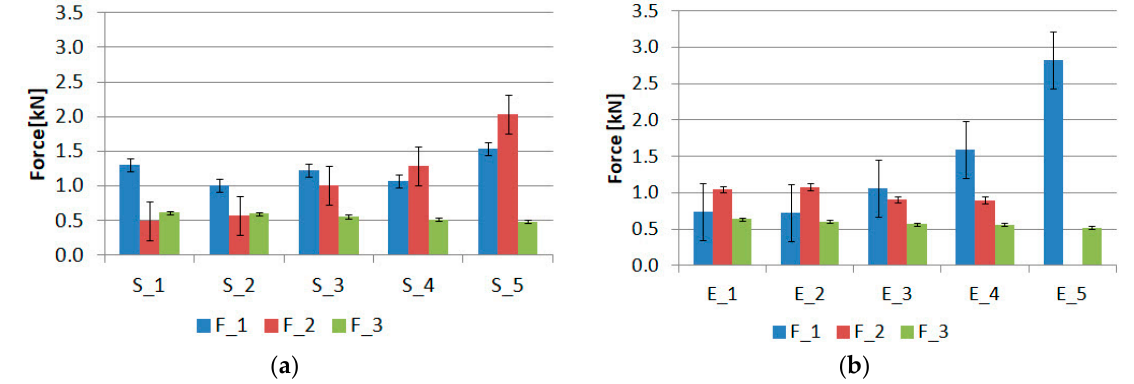
Figure 15. Summary of maximum forces for samples of group: ( a ) “S” and ( b ) “E”.